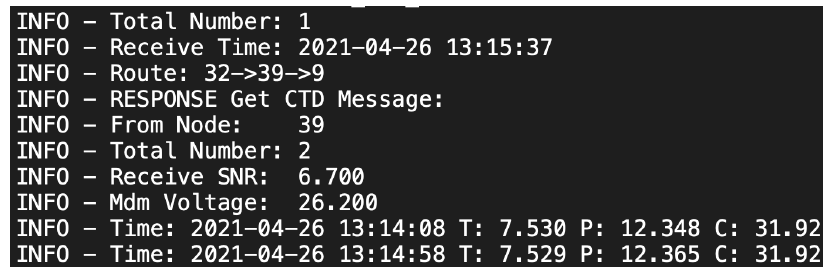
Figure 14. The CTD sensor data.